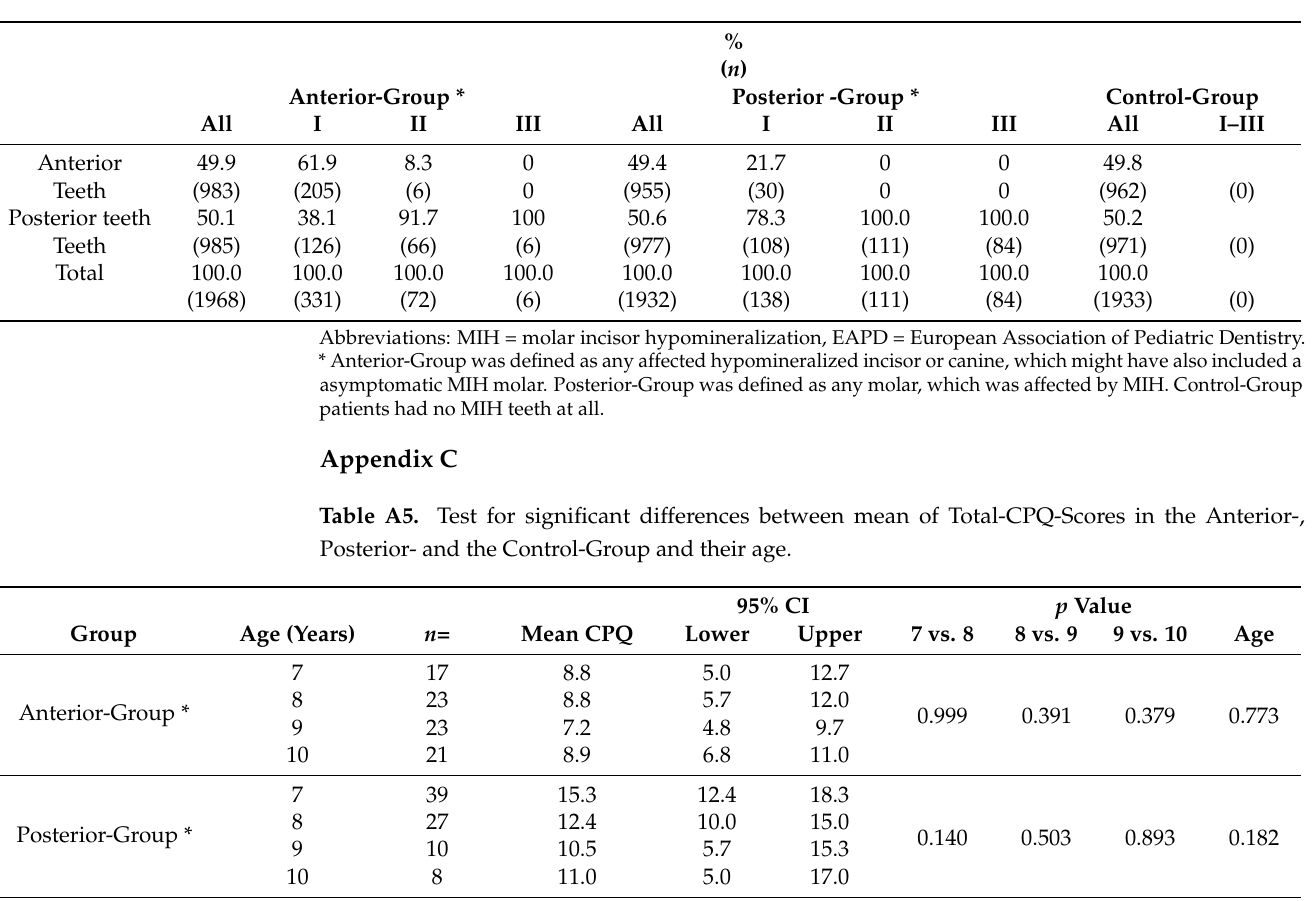
Table A4. Summary of data of 5833 teeth including MIH ( n = 742) with regard to localisation according to the EAPD-Criteria [3] and the MIH Classification by Mathu-Muju and Wright [29].